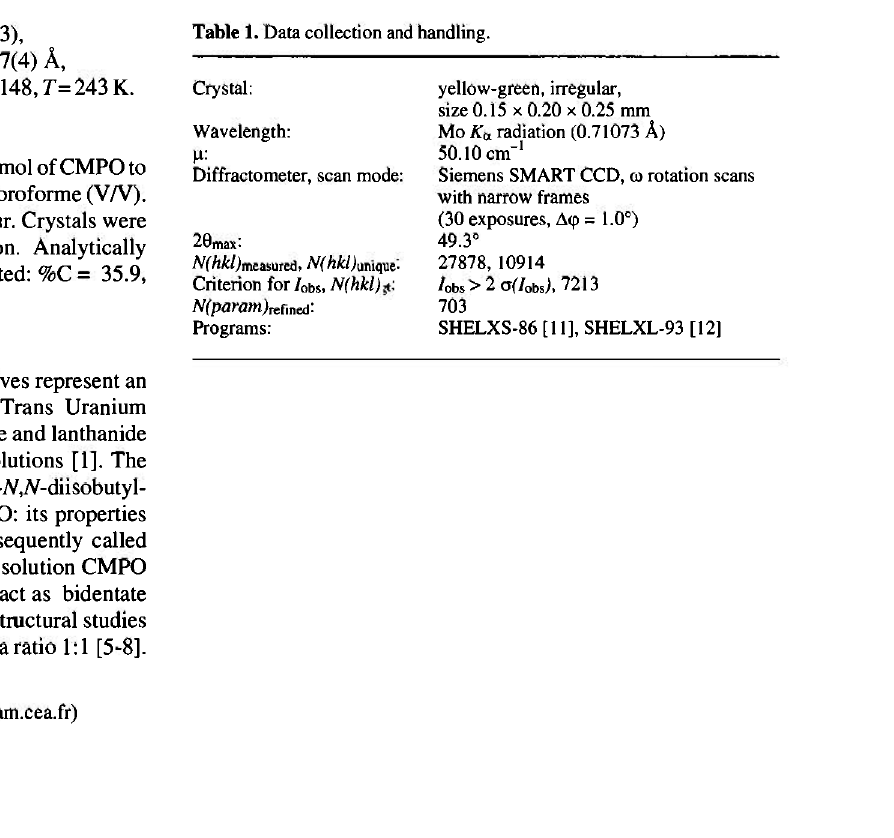
Table 1. Data collection and handling.